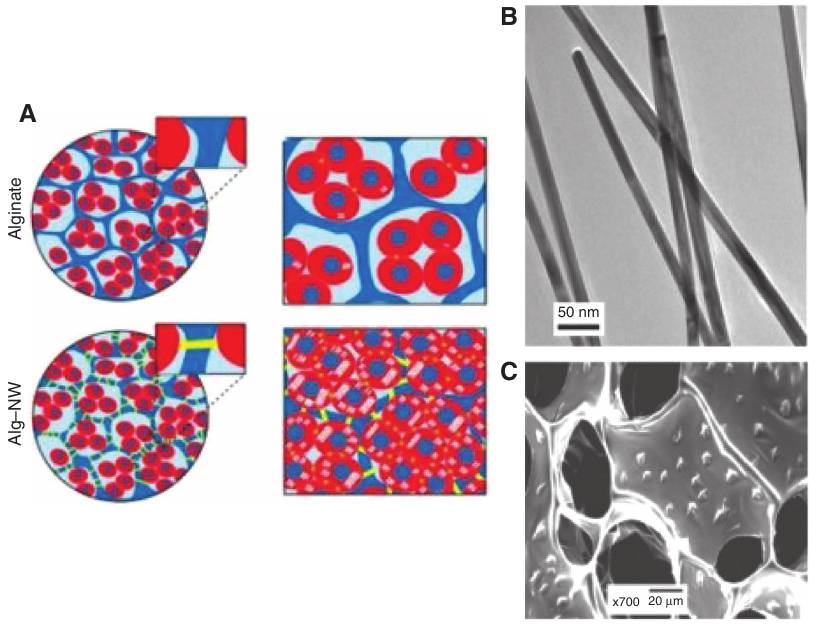
Figure 23: (A) The isolated cardiomyocytes are cultured in either pristine alginate or alginate–nanowire composites; cardiac cells (red), algi- nate pore walls (blue) and gold nanowires (yellow). (B) and (C) Vertical and horizontal cross-sectional images of incorporated nanowires within alginate scaffolds, respectively. The assembled wires were distributed homogeneously within the matrix. Reprinted with the permission of Macmillan Publishers Ltd: [Nature Nanotechnology] Ref. [52], Copyright